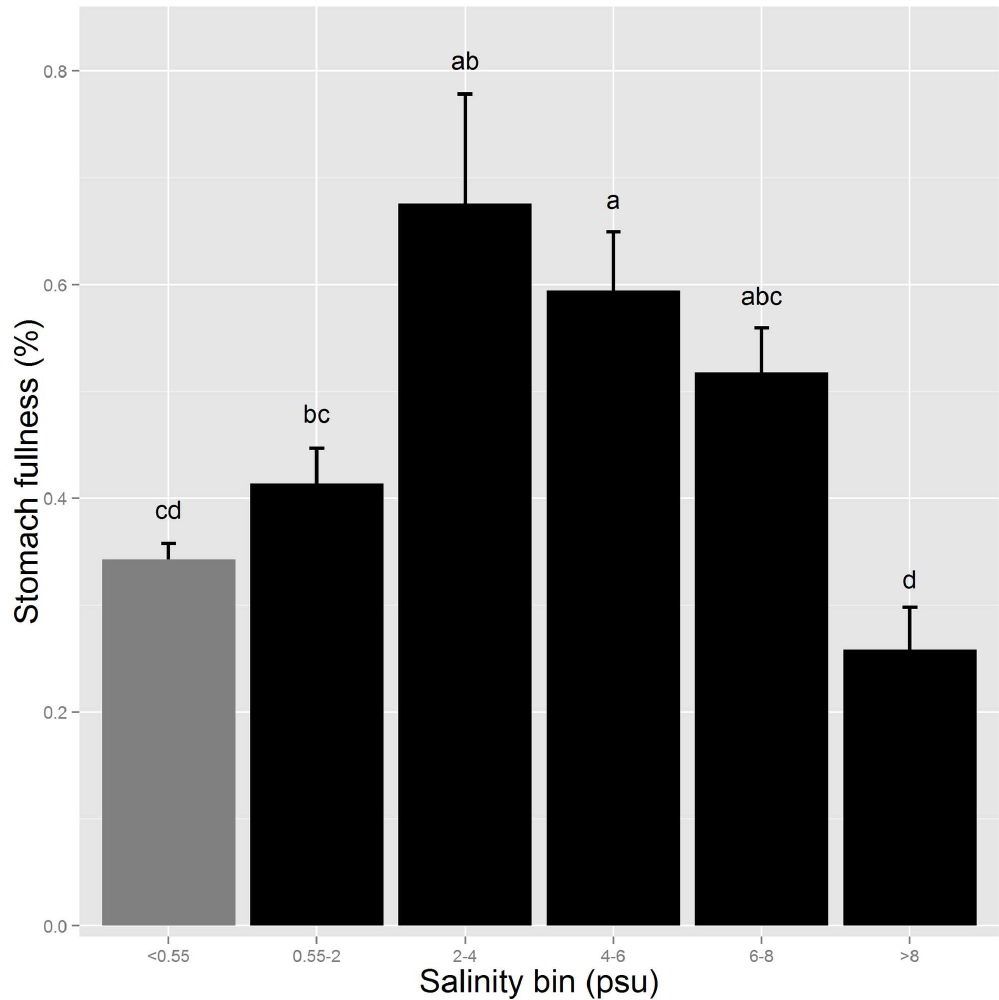
Fig 4. Mean stomach fullness (%) of Delta Smelt by salinity bin. The grey bar represents freshwater ( < 0.55 psu) and the black bars represent brackish habitat ( (cid:21) 0.55 psu). Samplesizes for each salinity bin from lowest to highestsalinity = 682, 193, 186, 112, 105, and 40. Differingletters denote statisticallysignificantdifferences. Error bars are